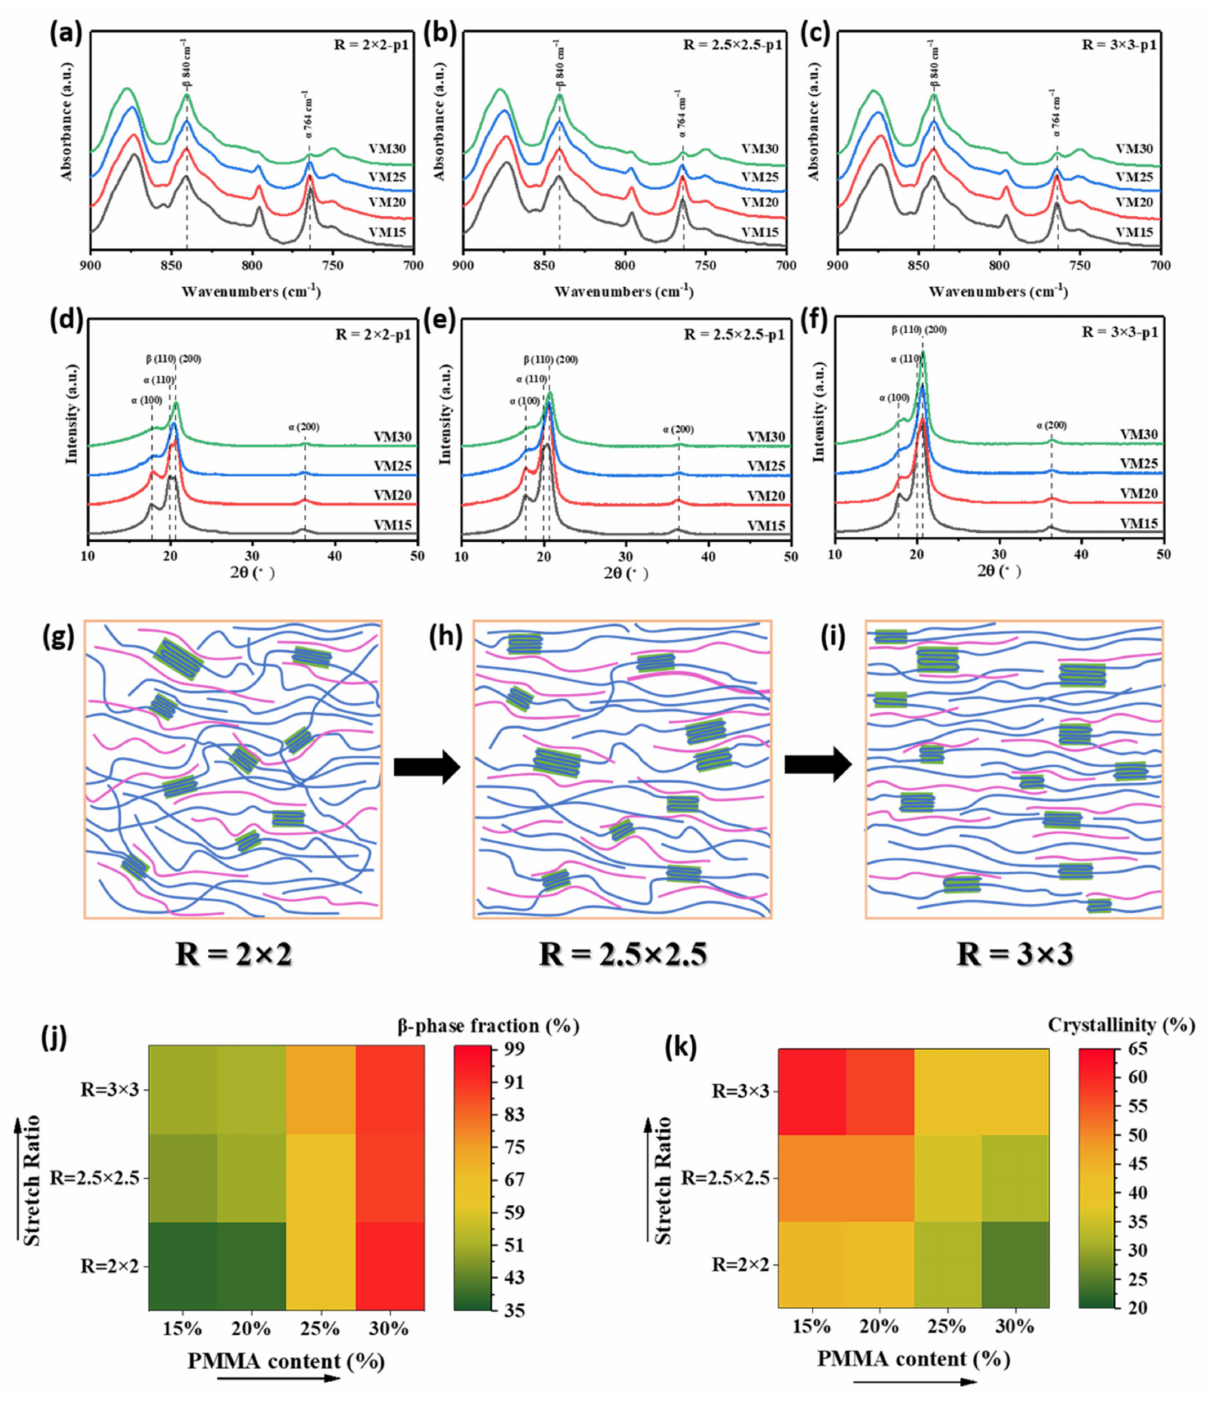
Figure 5. ( a – c ) FTIR spectra and ( d – f ) XRD patterns for the location of p1 in stretching VM films with ratios of 2 × 2, 2.5 × 2.5 and 3 × 3; ( g – i ) Schemes of crystal orientation in the film; ( j ) β phase fractions and ( k ) crystallinity versus PMMA content and stretching